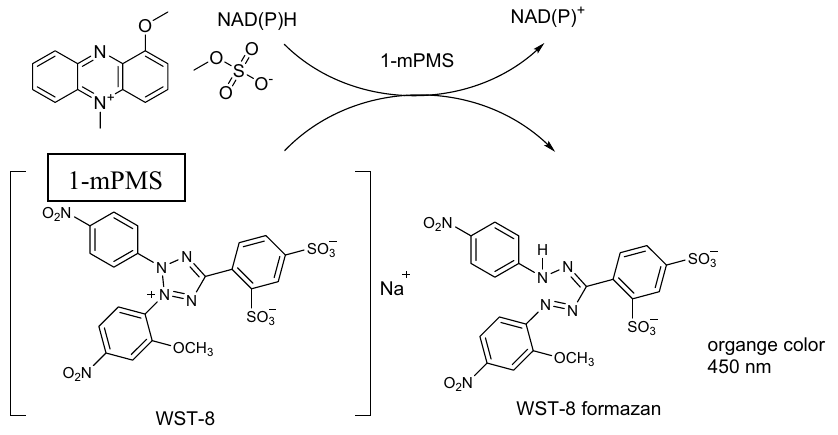
Figure 2. Schematic representation of the reaction for the detection of KRED activity using colorimetric WST-8 assay.